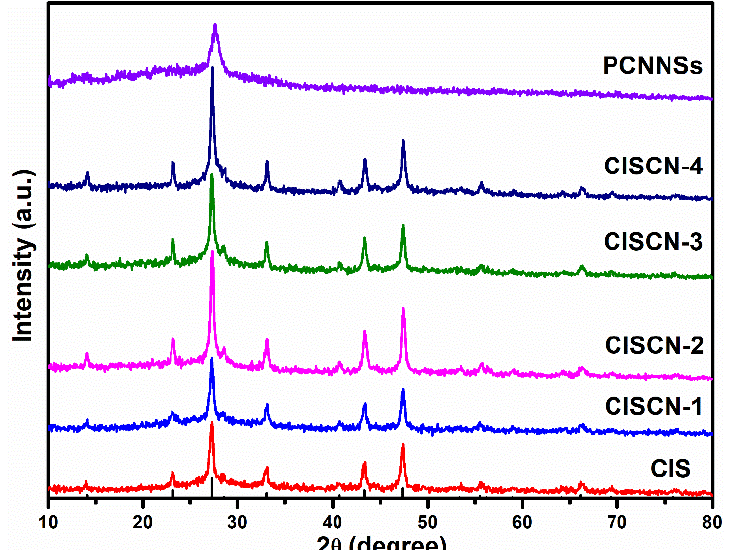
Figure 1. XRD patterns of the fabricated catalysts.